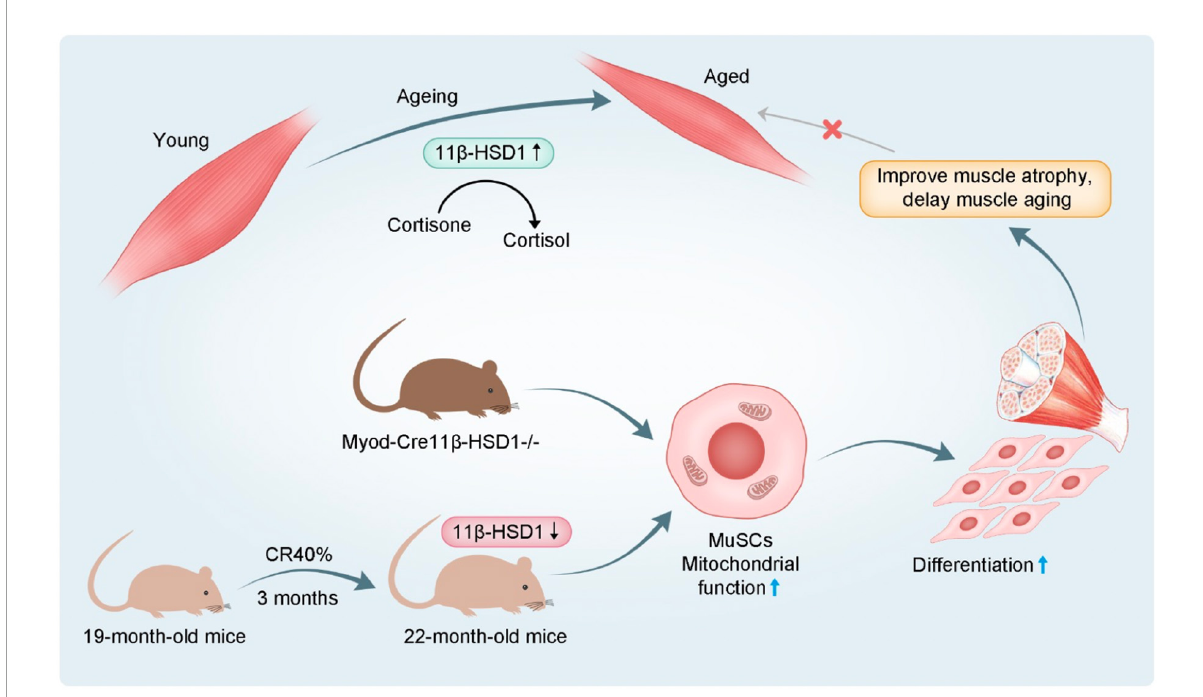
FIGURE7 Schematic diagram 1. 11 β -HSD1 expression level was increased in age-related muscle atrophy. 2. Muscle-specific 11 β -HSD1 knockout rescued age-related muscle atrophy. 3. CR promoted the mitochondrial function and differentiation ability of MuSCs by reducing 11 β -HSD1, thereby delaying muscle atrophy in aged